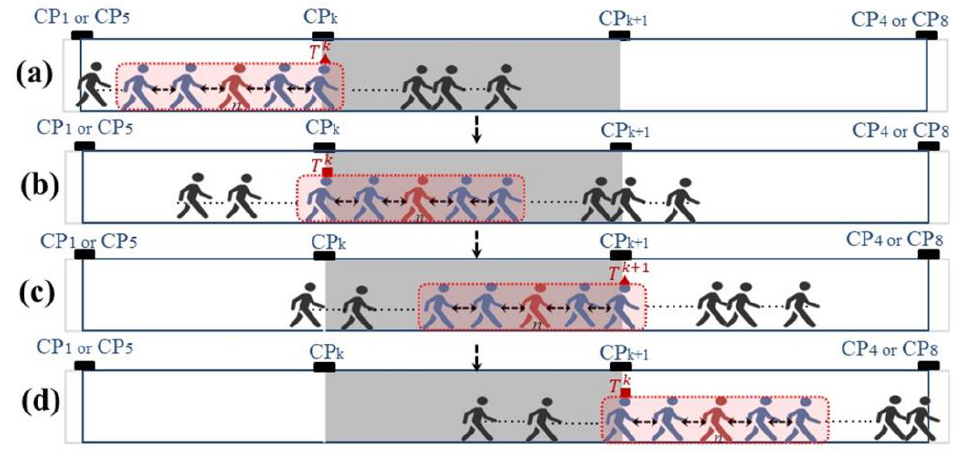
Figure 8. Schematic diagram of average interval time calculation.